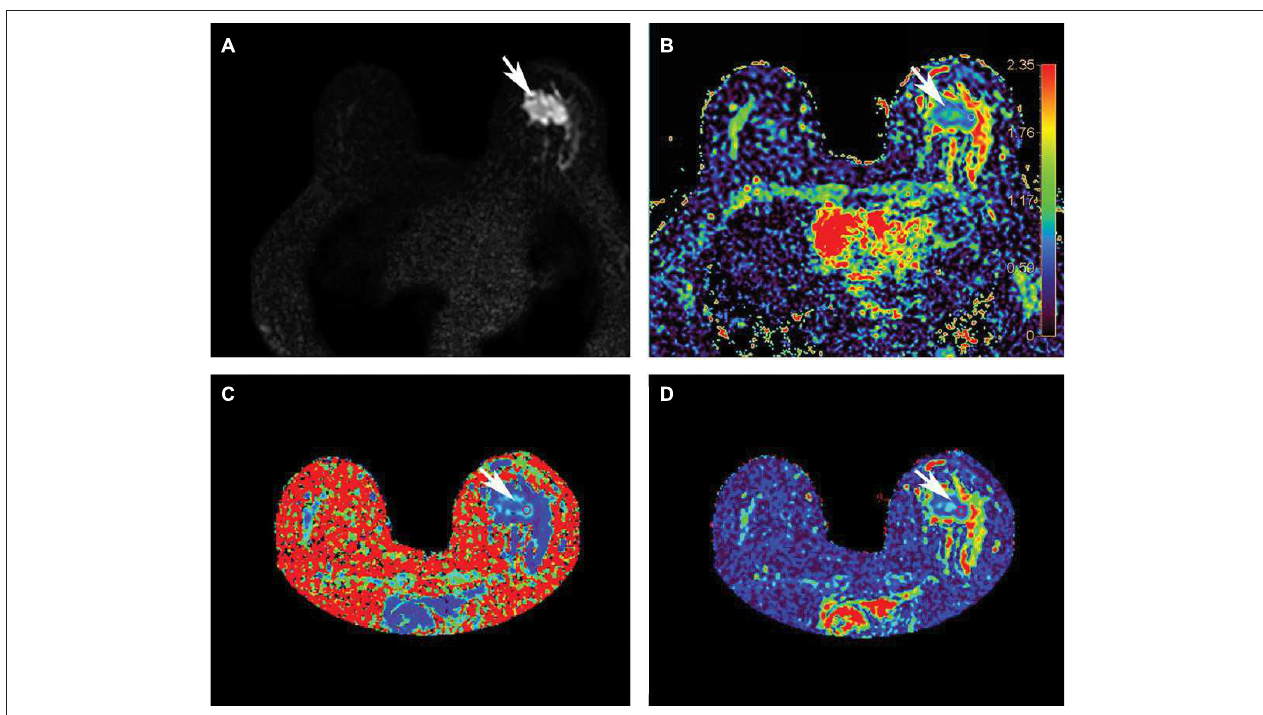
FIGURE 3 | A comparison of diffusion techniques and metrics from scanning a 57-year-old woman with left breast invasive ductal carcinoma (tumor indicated by the arrow) at 3T. (A) The baseline b = 0 image acquired without diffusion gradients; (B) conventional DWI: apparent diffusion coefficient (ADC) map (scale bar 0-2.35 mm 2 /s), arrow indicating tumor ADC value of 1.090 mm 2 /s; (C) diffusion kurtosis imaging: mean kurtosis map (scale bar 0-3 mm 2 /s), arrow indicating tumor mean kurtosis value of 1.154 mm 2 /s; (D) DTI: mean diffusivity map (scale bar 0-2.8 mm 2 /s), arrow indicating tumor mean diffusivity value of 0.808 mm 2 /s. Reprinted